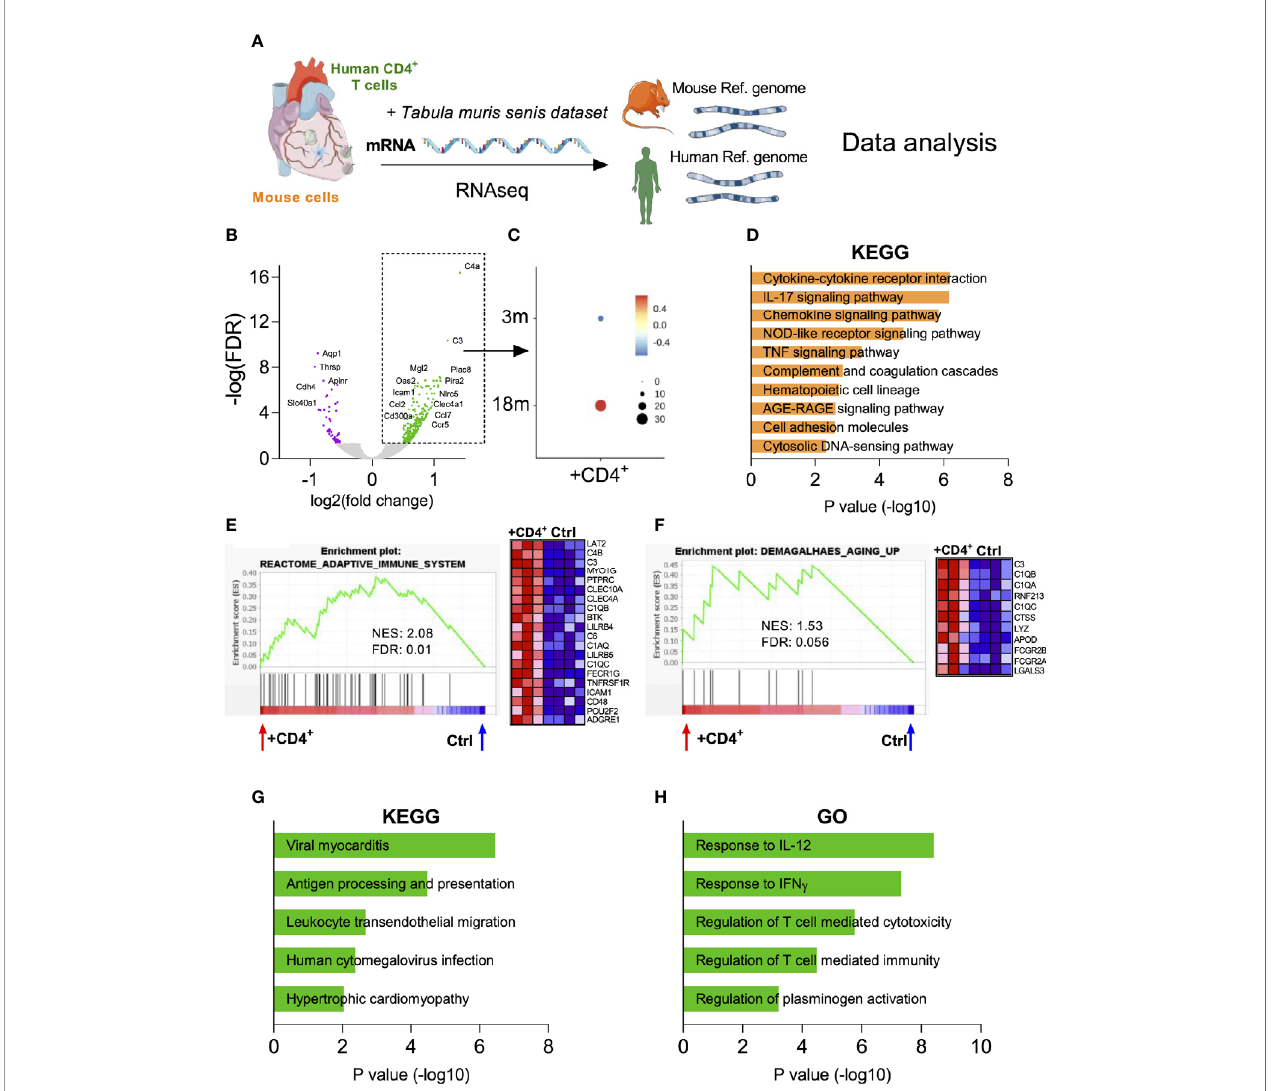
FIGURE 5 | Transcriptome analysis reveal an in fl ammaging phenotype in the heart of CD4 + T cell transferred NSG mice. (A) Myocardial mRNA extracted from control and T cell transferred NSG-DR1 mice was employed in RNA-seq analysis. Transcripts were aligned against mouse genome and human genes were selected using the Xeno fi lteR tool and further integrated with other publicly available datasets. (B) Volcano plots comparing the gene expression levels in myocardial tissue of T cell transferred NSG-DR1 mice versus control. The upregulated and downregulated genes (± 0.5 – 1.5 log2 fold, FDR<0.05) are highlighted in green and purple respectively. (C) The myocardial upregulated gene set identi fi ed in (B) was then probed in other myocardial aging datasets publicly available [ Tabula muris senis (19)]. A score of the average expression levels (colored scale) and fraction of cells expressing the signature (circle sizes) was analyzed at single-cell level on myocardial samples obtained from 3- and 18-months old mice (3M and 18M respectively). (D) KEGG analysis of upregulated mouse transcripts from T cell transferred NSG- DR1 hearts. The bars represent the adjusted P value (Fisher ’ s exact test). (E, F) GSEA analysis of “ reactome adaptive immune system ” and “ Demagalhaes aging up ” (36) in the myocardium of control and T cell transferred NSG-DR1 mice. Normalized enrichment score (NES) and FDR are depicted in the graphs. The heatmaps illustrate the genes differently expressed at each gene set. (G, H) KEGG and gene ontology (GO) analysis of upregulated human transcripts found in the myocardium of T cell transferred NSG-DR1 mice. The bars represent the adjusted P value (Fisher ’ s exact test). Data from control (n: 4) and CD4 + T cell transferred (n: 3) were acquired from two independent